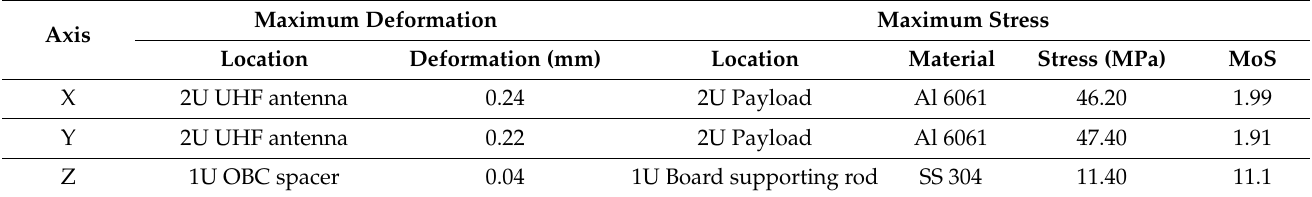
Table 2. Quasi-static acceleration analysis